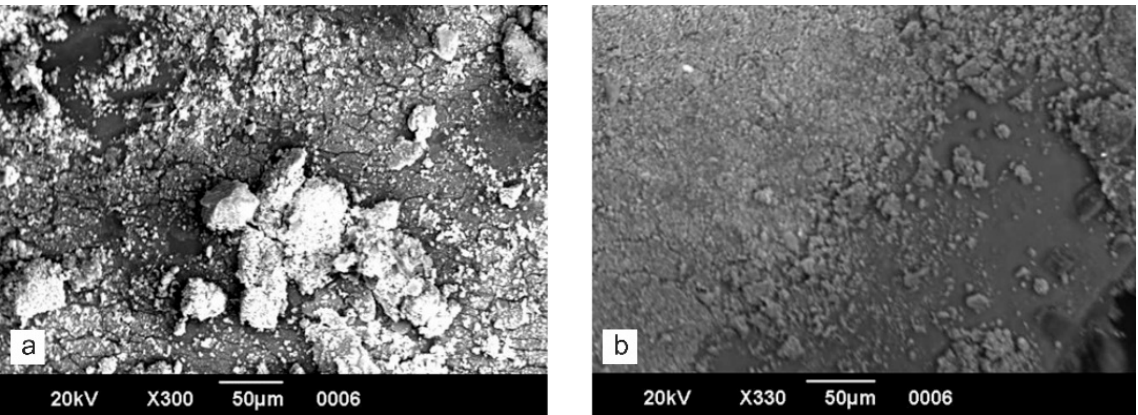
Figure 7. SEM images of pipe surface from ( a ) well 8-o and ( b ) well 7-o.